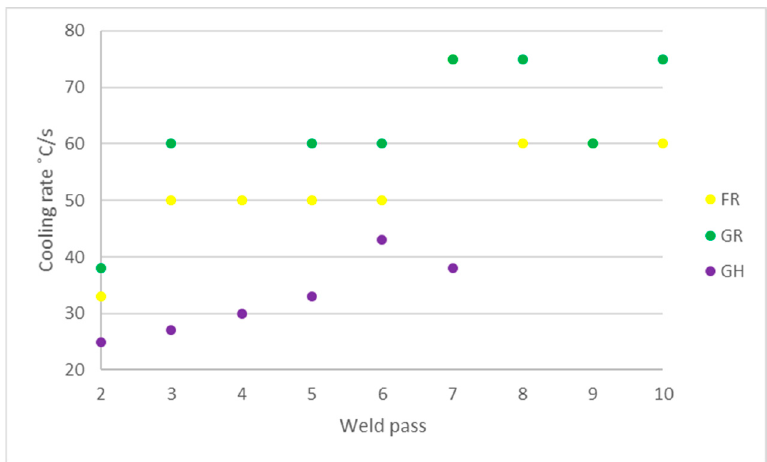
Figure 7. Average cooling rate between 1200 and 800 °C vs. weld pass number and welding procedure. Data for GR weld in Weld Pass 4 is not available because of a failure in the software that monitored the temperatures. The GH weld had only seven weld passes, which is why there are no data for Weld Passes 8, 9, and 10. Weld Pass 7 for FR and GR welds had exactly the same cooling rate (75 °C/s), which is why only one point is shown.